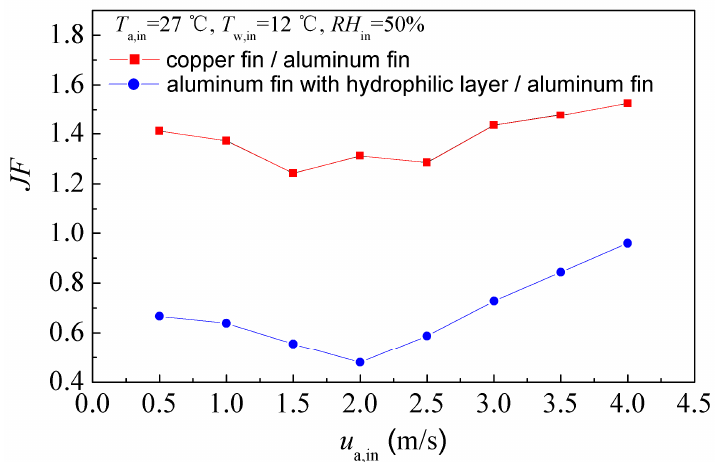
Figure 13. Effect of u a,in on JF .